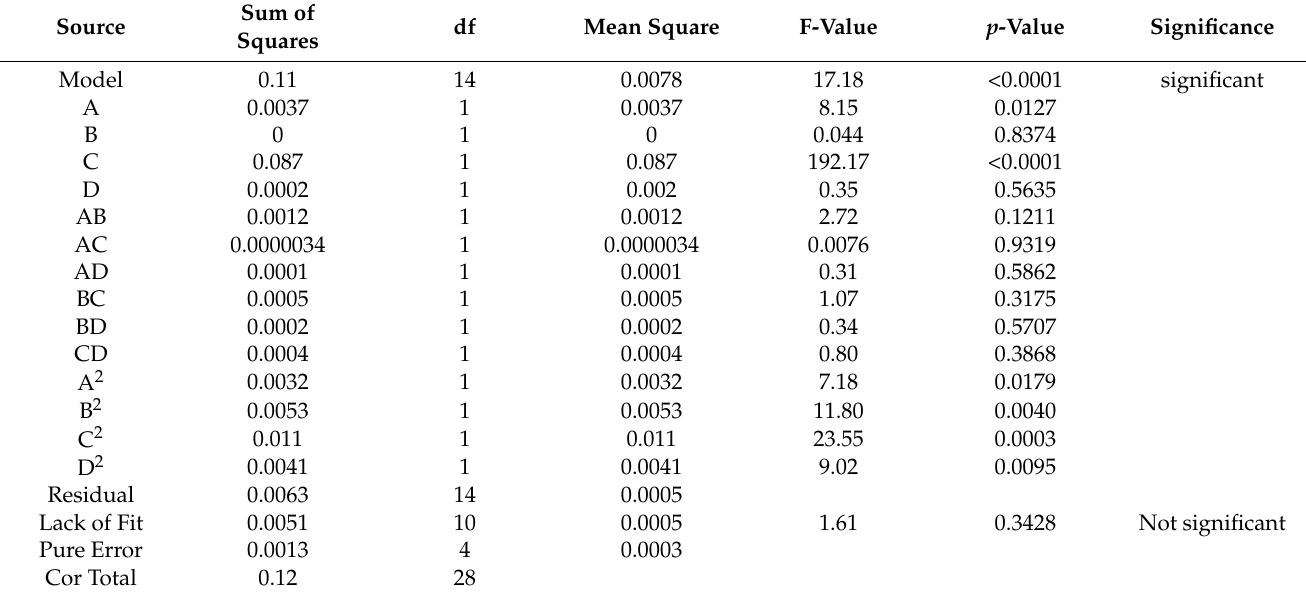
Table 5. Analysis of variance of the mycelial biomass response surface model of the strain